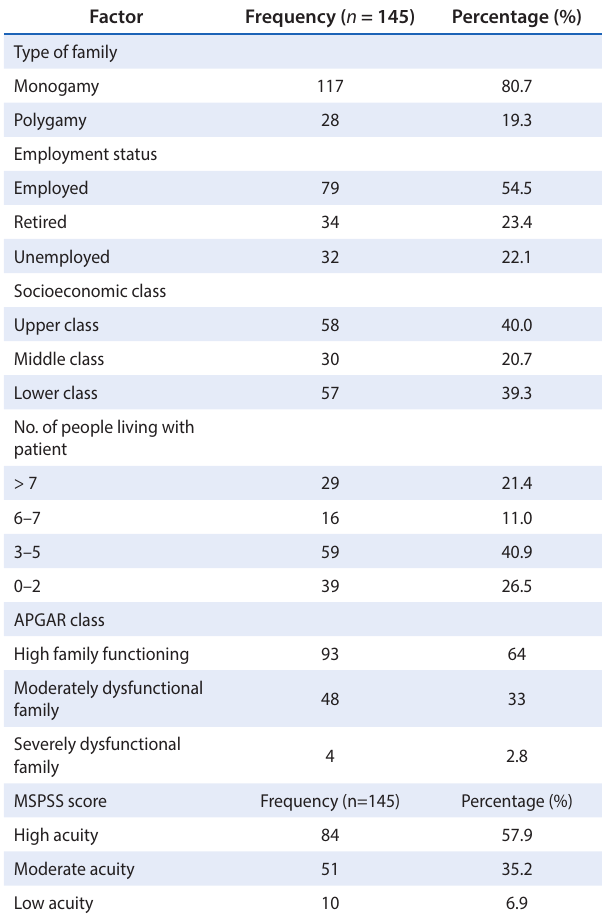
Table 1: Frequency distribution of family characteristics of the type 2 diabetes